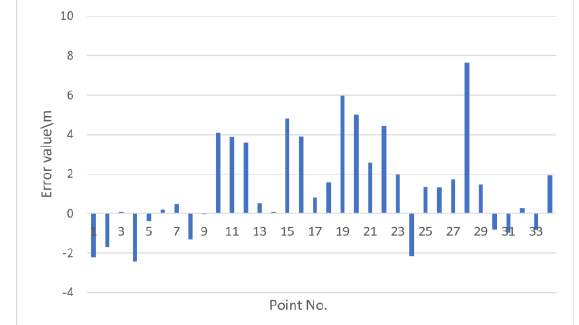
Figure 7. Error Distribution of Elevation Accuracy